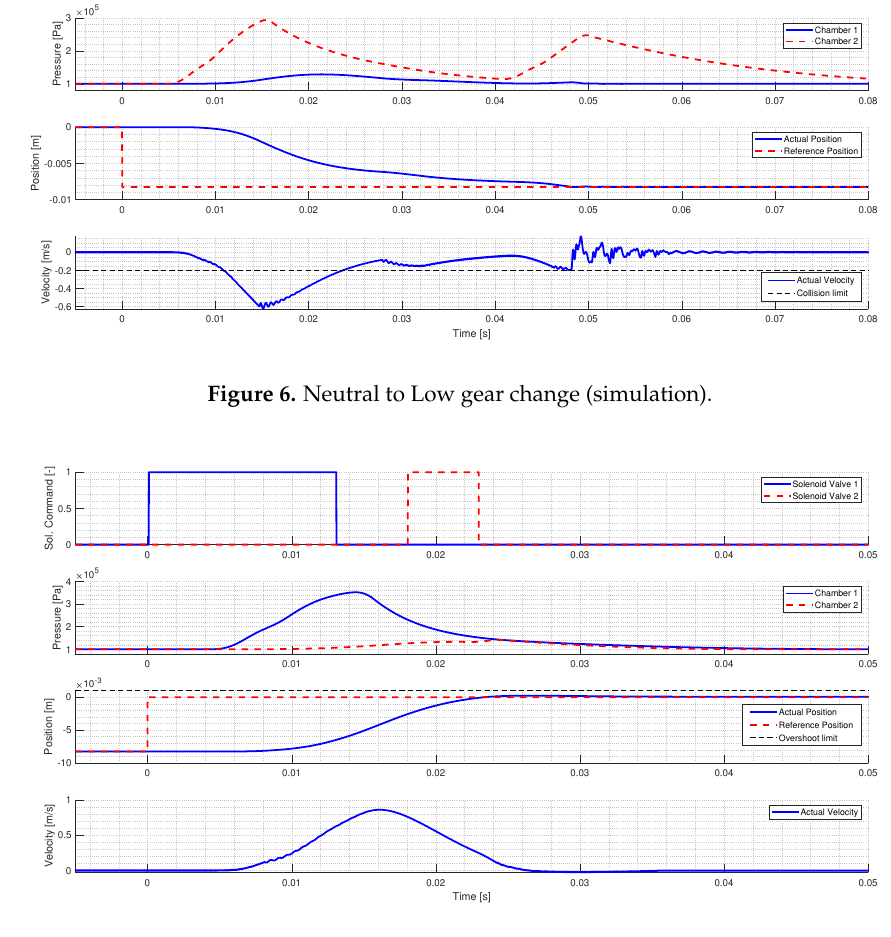
Figure 7. Low to Neutral gear change